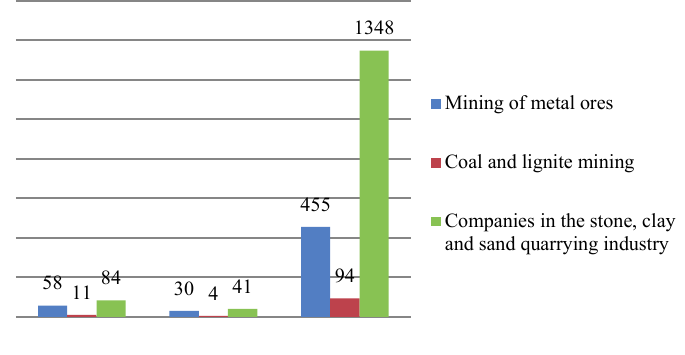
Fig. 6. The number of registered subsoil users in Kazakhstan.